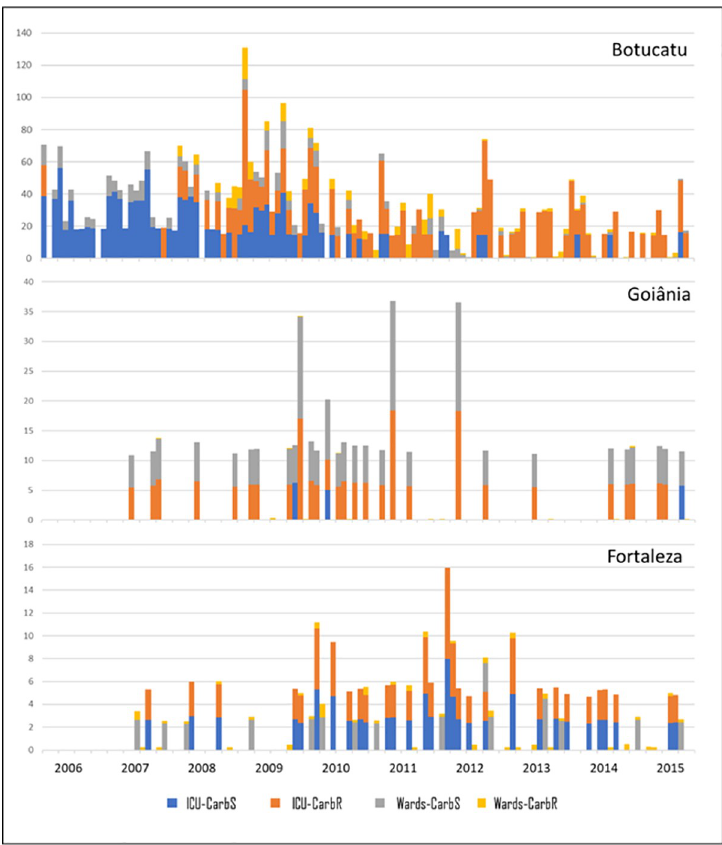
Fig 2. Monthly incidence of Acinetobacter baumannii bloodstream infections in three hospitals from different places in Brazil. Note . ICU, intensive care units; Wards, units for non-critically ill patients; Carb-R, carbapenem- resistant; CARB-S, carbapenem-susceptible.